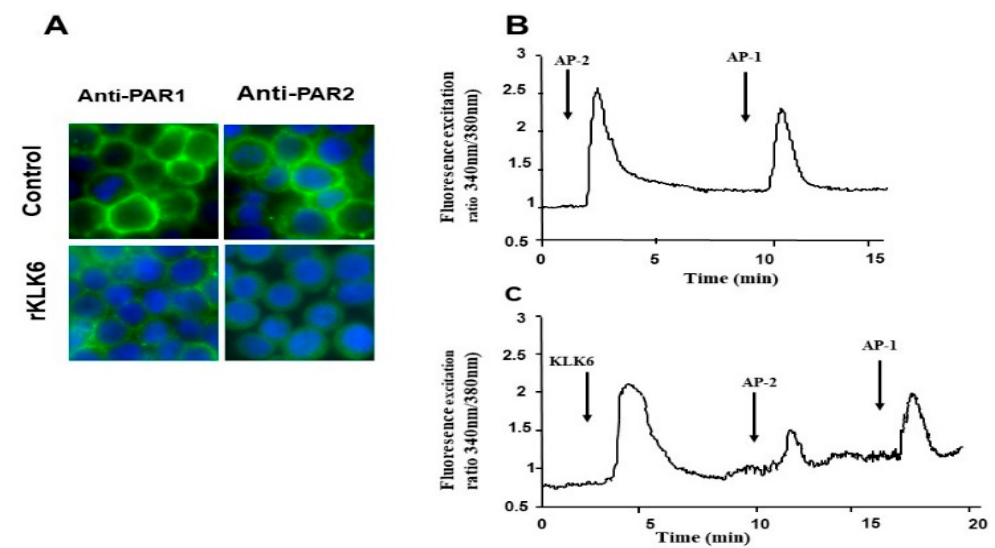
Figure 3. KLK6 induces loss of PAR1 and PAR2 from the surface of HT-29 cells and initiates calcium signaling via PAR2. ( A ) Immunofluorescence detection of PAR1 and PAR2 in HT-29 cells pre-treated with KLK6 (20 nmol/L), or with vehicle (control) for 15 min at 37 ◦ C. Cells were fixed using 2% paraformaldehyde and immunostained with a PAR2 monoclonal antibody or PAR1 monoclonal antibody. Results are representative of two independent experiments (Magnification × 630). ( B , C ) KLK6 initiates intracellular Ca 2+ mobilization. HT-29 cells were loaded for 60 min at 37 ◦ C using Fura 2/AM. ( B ) HT-29 cells were challenged first with AP2 (SLIGKV-NH 2 , 100 µ mol/L)) and AP1 (TFFLLR-NH 2 , 100 µ mol/L). ( C ) Cells were first challenged with KLK6 (1 µ mol/L) followed by a second challenge with activating peptide AP2 (100 µ mol/L) and subsequent challenge with AP1 (100 µ mol/L). Note the AP2 response showed a reduction in response, whereas cells were still responsive to AP1. Administration of compounds is indicated with the corresponding arrows.